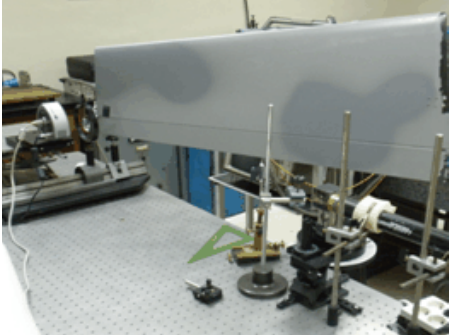
Figure 2. Experimental set-up employed. The picture corresponds to the measurement at a point located on the extreme of the wing flap (the length of the wing is 1.30 m,